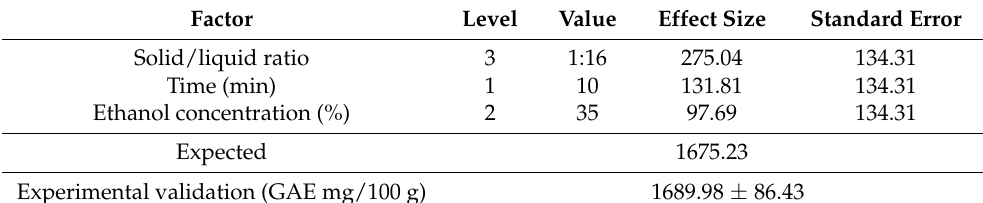
Table 3. Optimal extraction conditions.